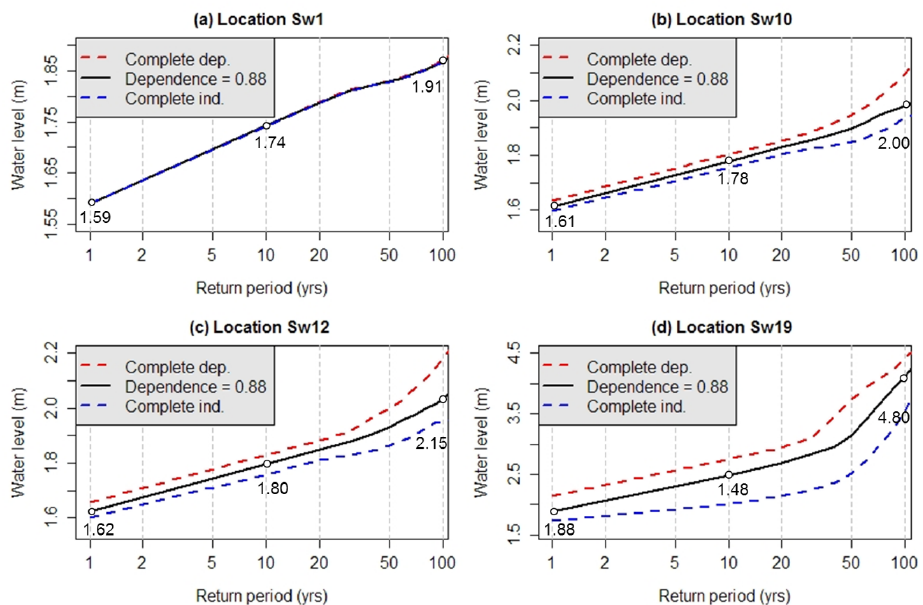
Figure 9. Results of Method 3 applied to locations Sw1, Sw10, Sw12 and Sw19. The complete dependent and independent cases are estimated using an α value of 0 and 1, respectively (see Sect. 4.3). Table 1. Flood estimation results comparison. Loc.